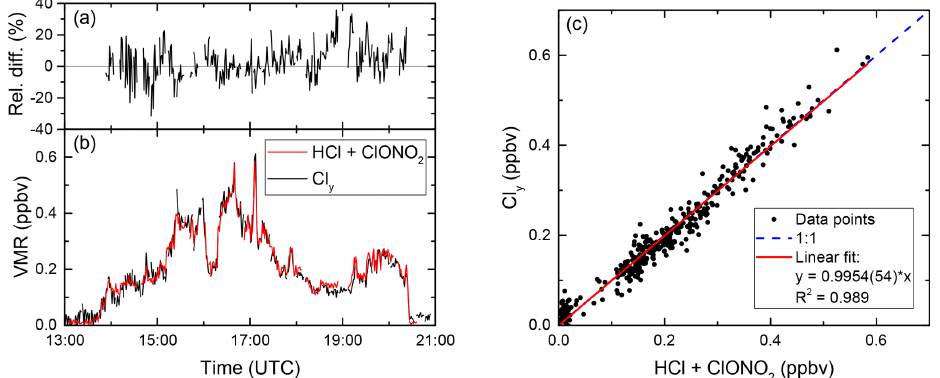
Figure 2. Comparison of the sum of HCl and ClONO 2 , measured by AIMS, to Cl y , inferred from GhOST measurements, during flight 04 on 17 December 2015. (a) Difference between both curves relative to Cl y and (b) timeline of mixing ratios over the whole course of the flight. (c) Correlation between added AIMS measurements and Cl y .